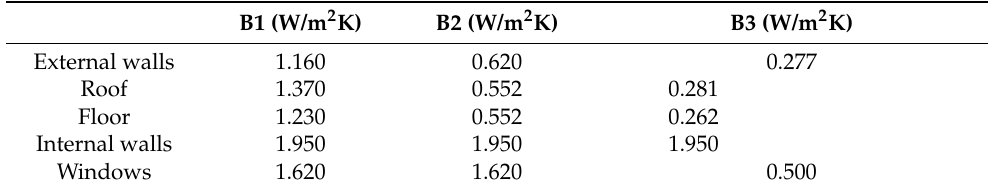
Transmittance values of building envelope components for the three different buildings considered.